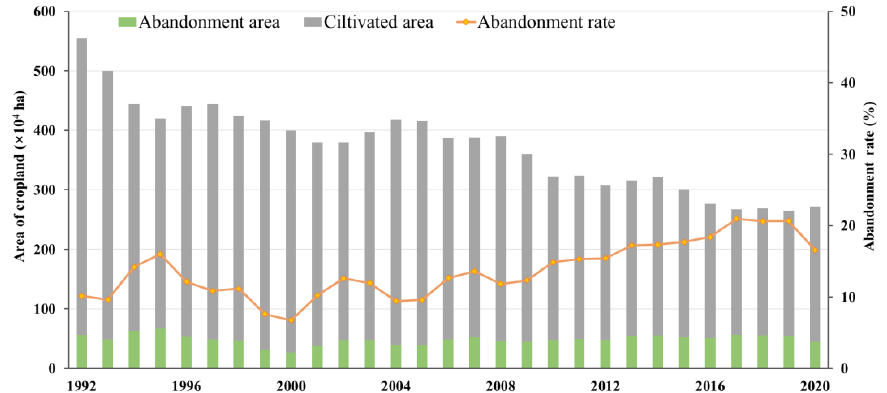
Figure 14. Temporal trends from 1992 to 2020 based on annual abandonment area, cultivated area, and abandonment rate. and abandonment